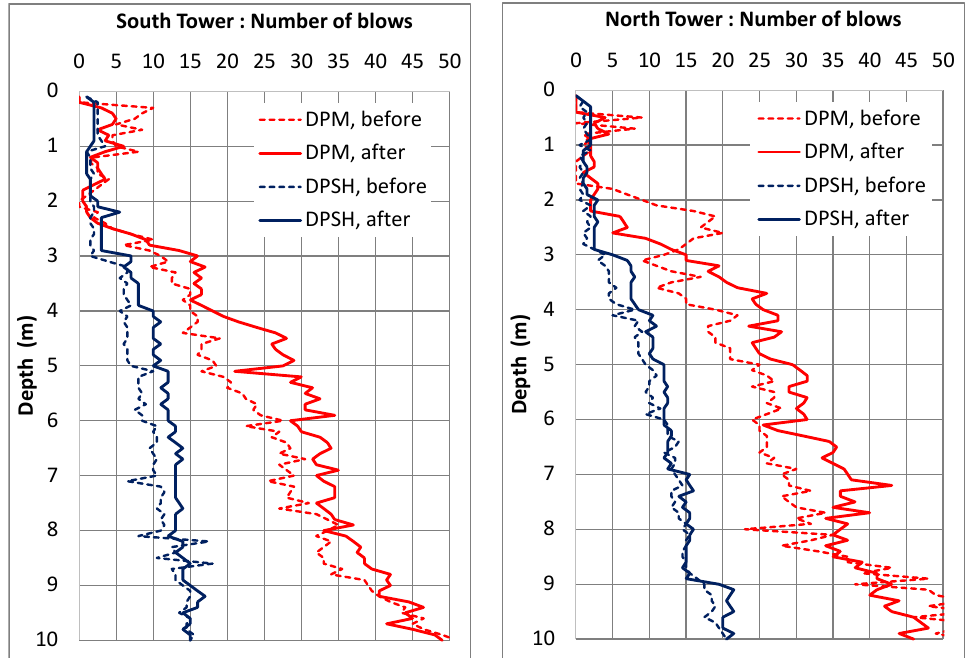
above the injection point next to the wall. Settlement from 10 July 2018, at 08:42, until the next day, 11 July 2018, at 07:49 are shown in Figure 25.